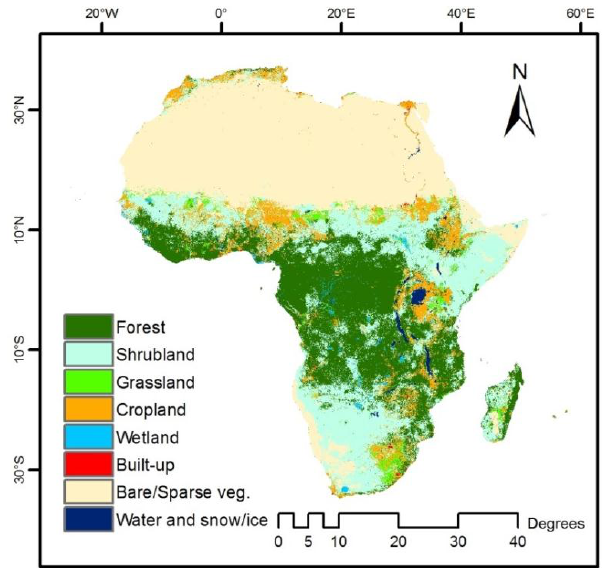
Figure 9. Integrated LC map based on RK method.